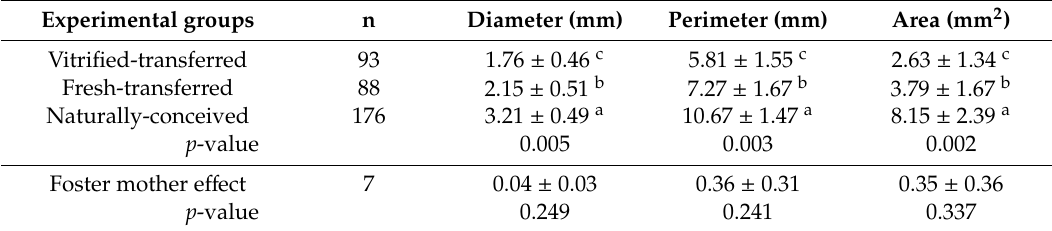
Table 1. Morphometric analysis of 6-day-old embryos after in vivo development by natural conception or following fresh or vitrified embryo